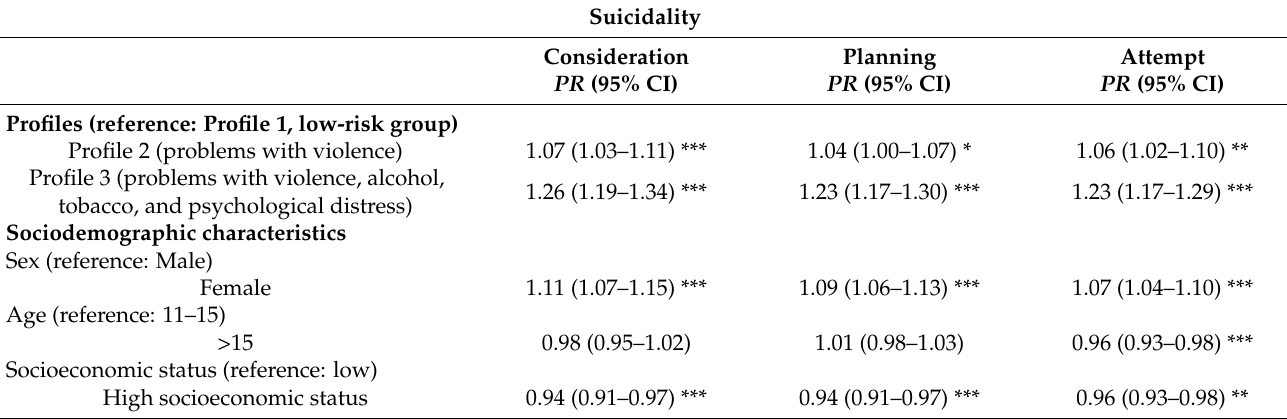
Table 5. Association between suicidality and profiles in adolescents aged 11–18 in Mauritius,